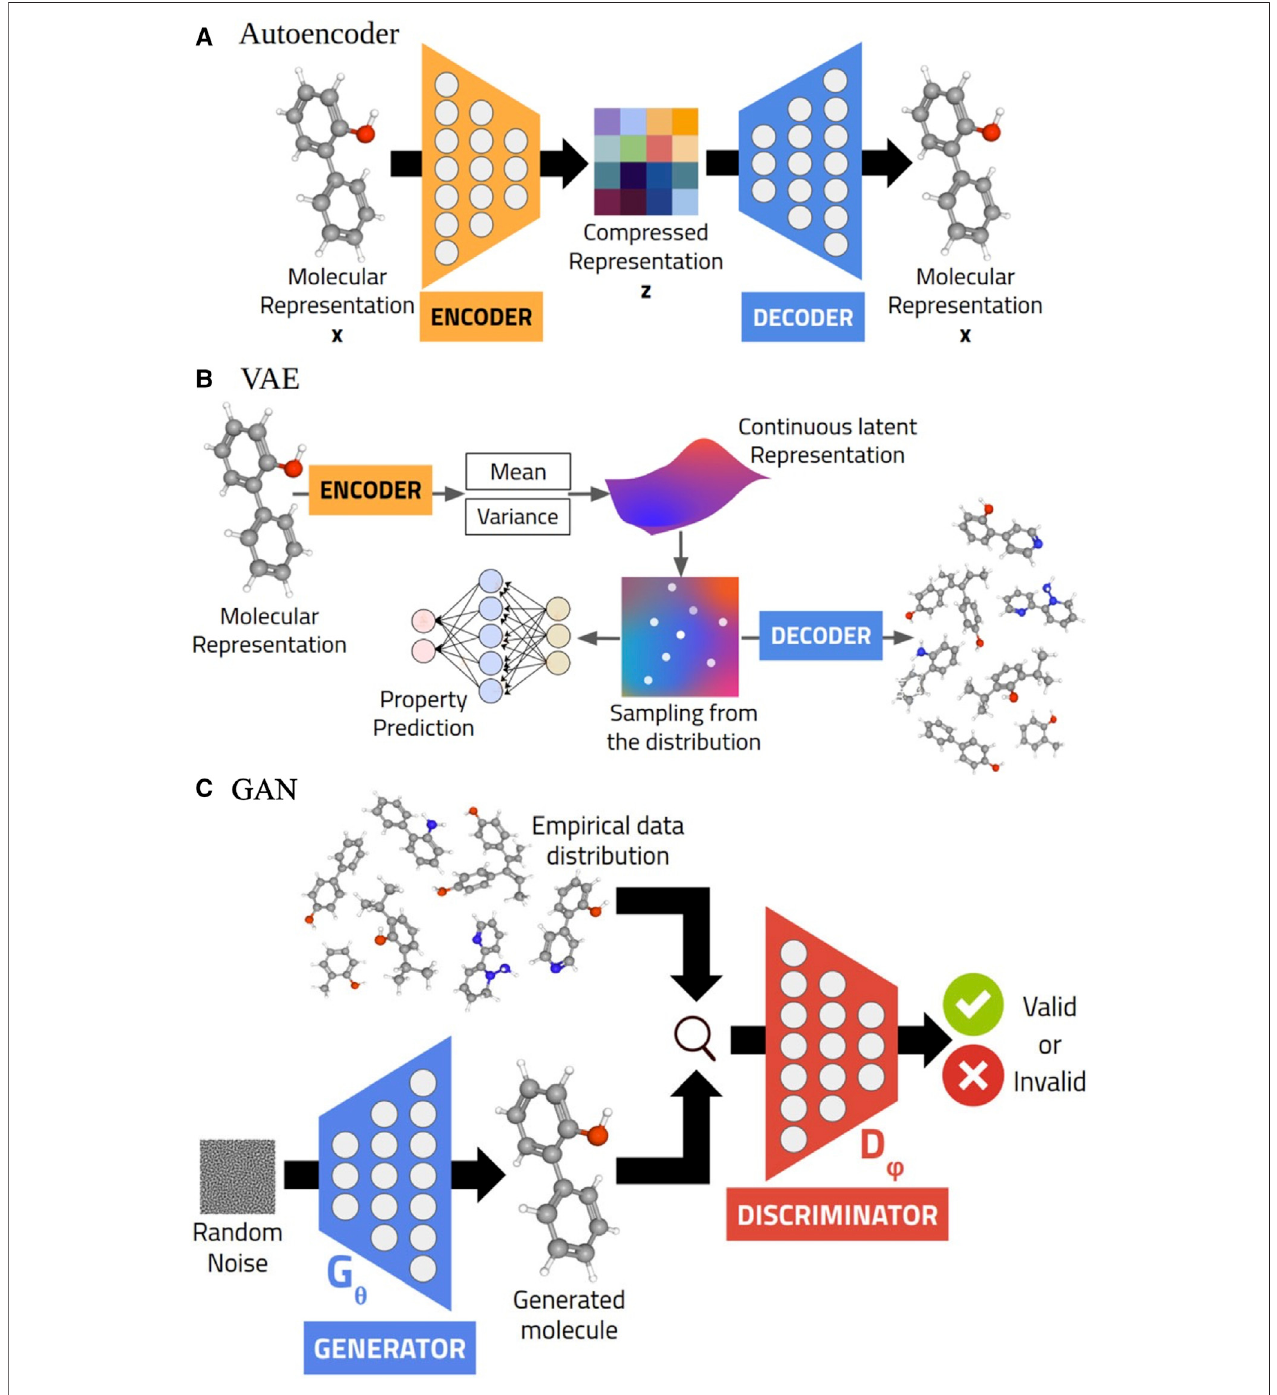
FIGURE 1 | Generative models typically used in molecular generation: AE (A) , VAE (B) , and GAN (C) . Reprinted with permission from Karthikeyan et al. (2021).